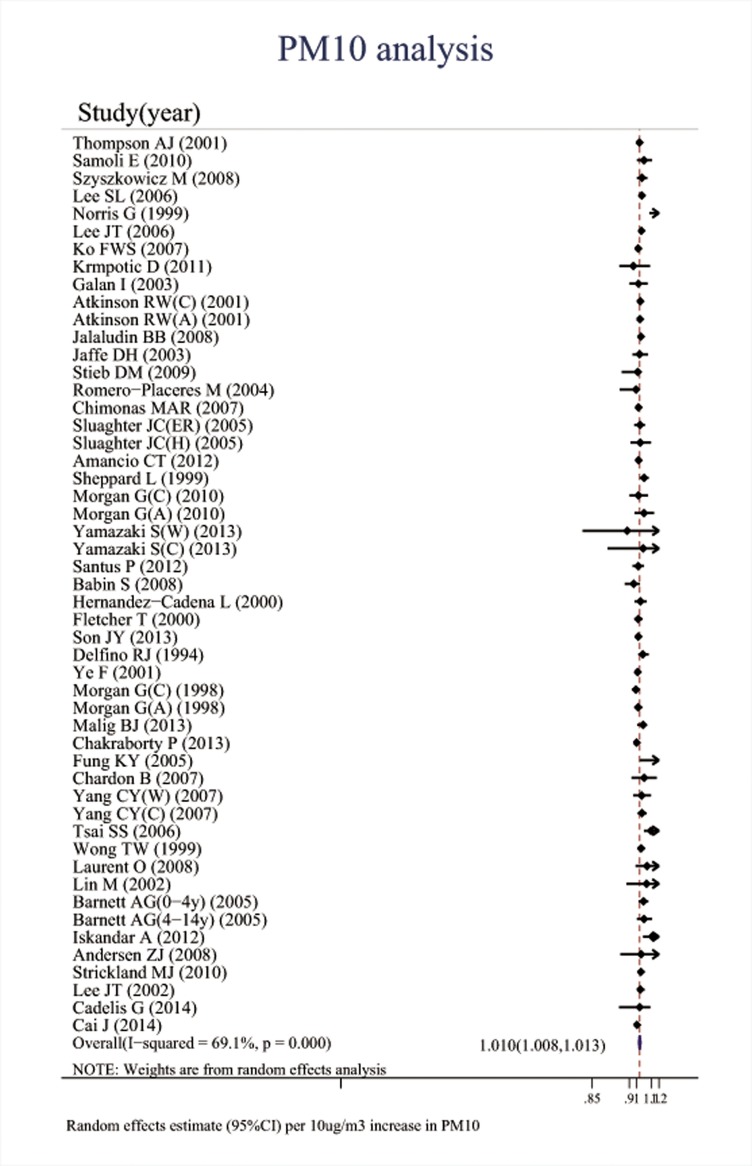
Association between PM10 and ERVs/hospital admissions for asthma in the overall analyses.